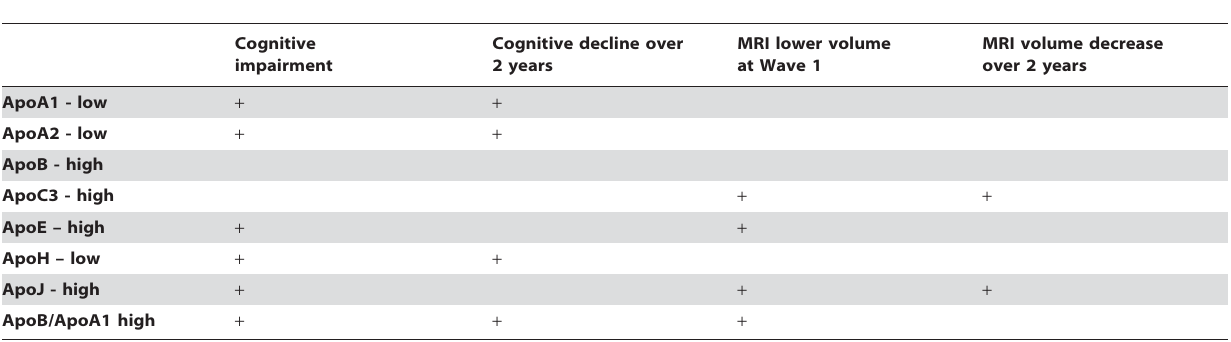
Table 8. Summary of correlations between apolipoproteins and cognitive impairment, cognitive decline and MRI changes over 2 years.